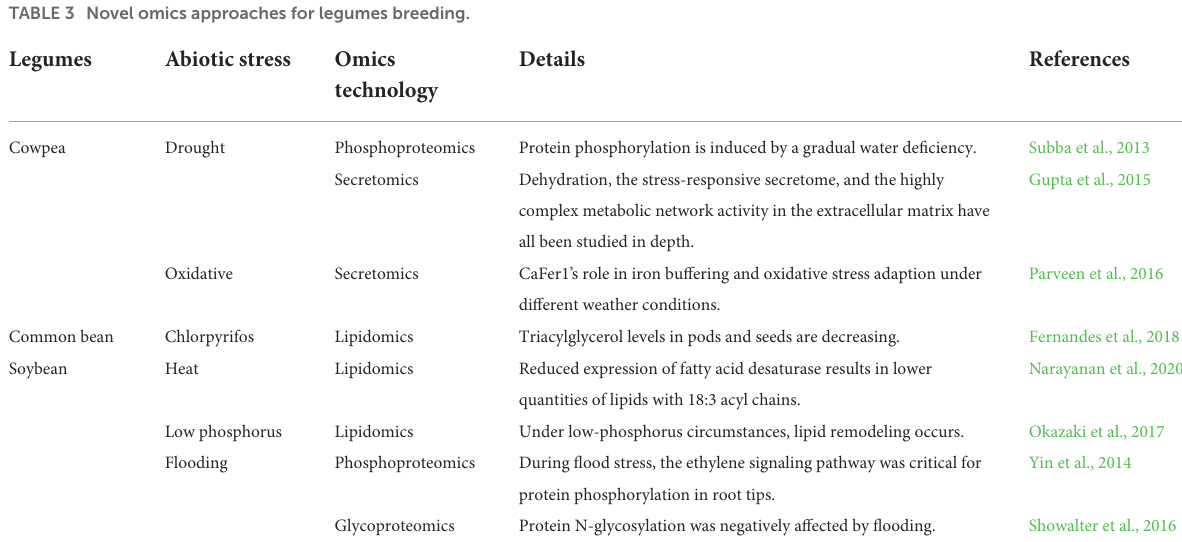
TABLE 3 Novel omics approaches for legumes